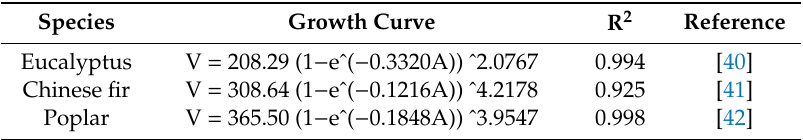
Table 3. Timber production (m 3 ha − 1 ) by different tree species estimated by allometric growth 321 models. 322